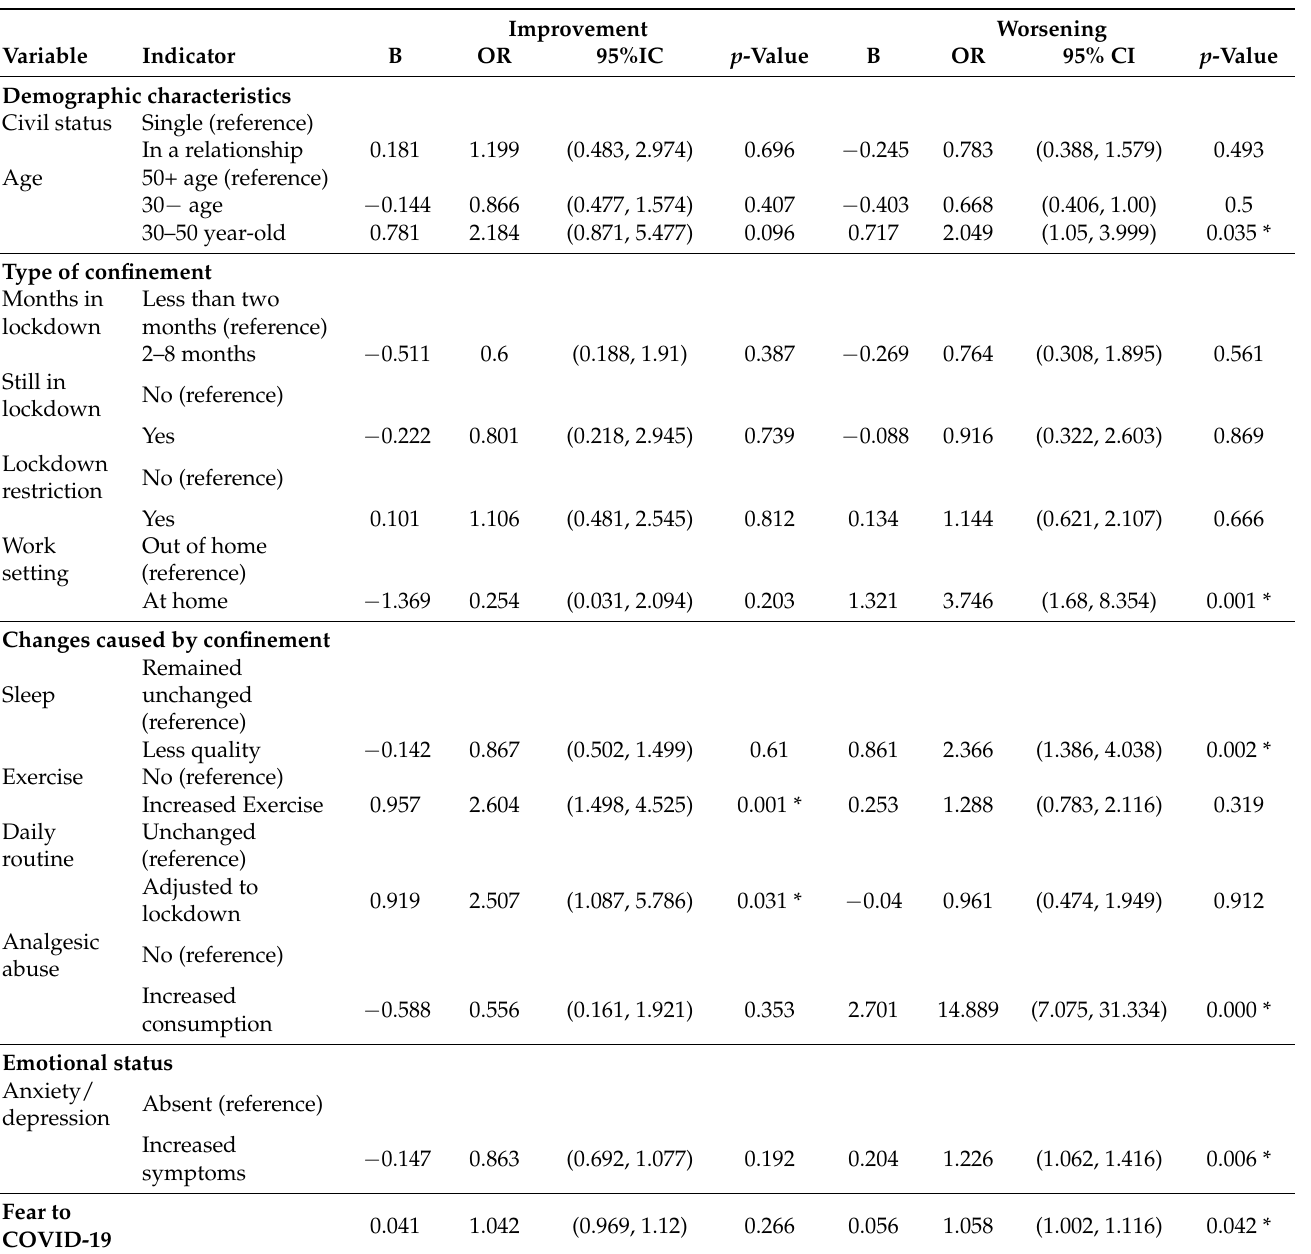
Table 2. Multinomial logistic regressions for improvement and worsening migraine (symptoms remained unchanged as reference) and demographic characteristics of patients, type of confinement, changes caused by confinement, emotional status, and fear of